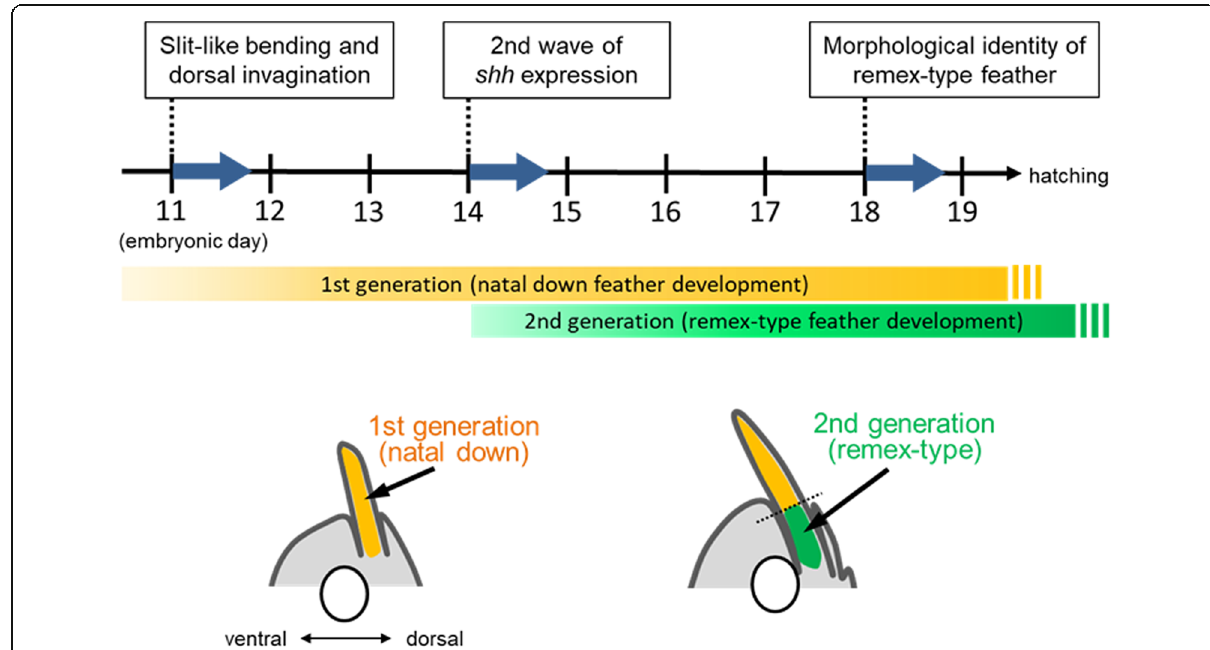
Fig. 6 Schematic representation of the developmental process of feather formation in the FFF region. Illustrated images in the lower column indicate posterior halves of transverse sections of the developing wing buds with a feather bud in the FFF region and ulna (ellipse). See the text for